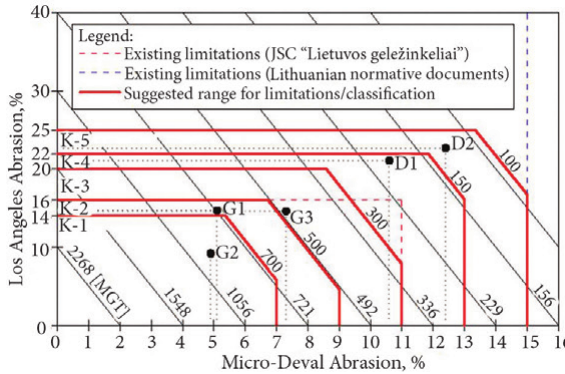
Fig. 7. Classification of Micro-Deval Abrasion and Los Angeles Abrasion indicators as sleepers are made of